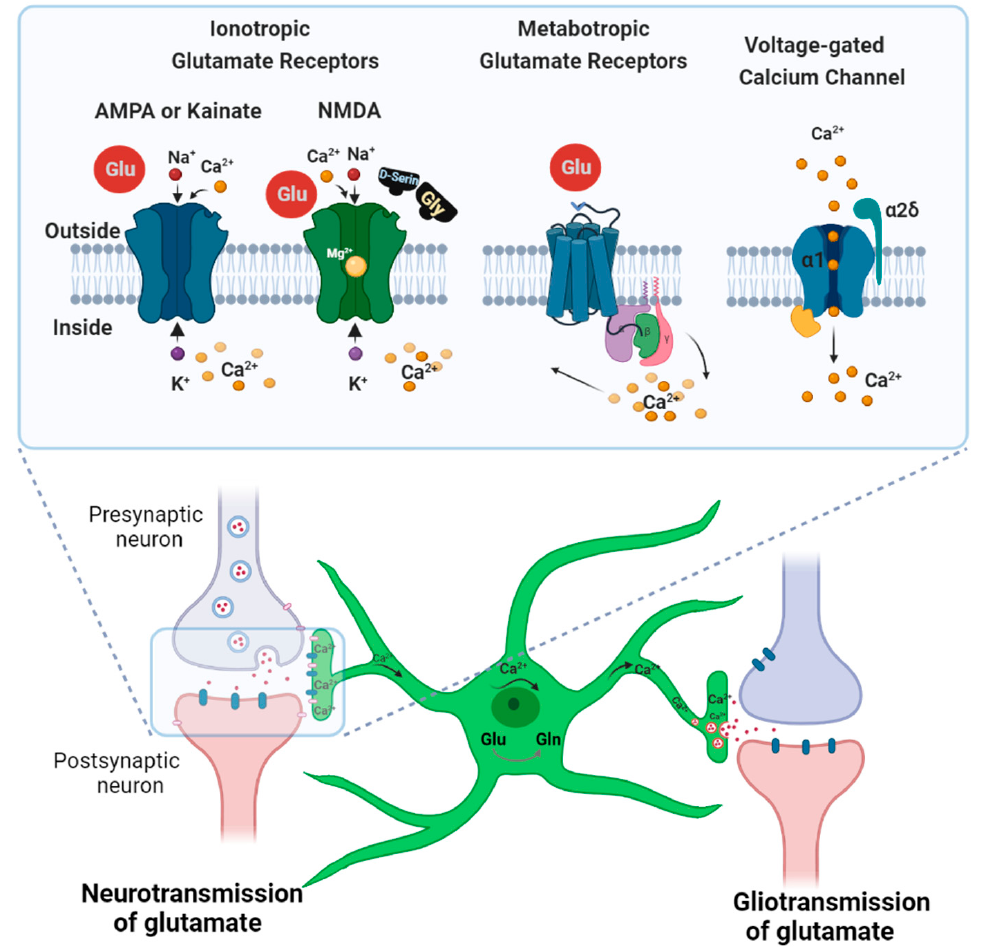
Figure 3. Scheme outlining glutamate and calcium signaling in astrocytes at a glutamatergic synapse. Astrocytes respond to glutamate stimulation with a strong calcium influx, followed by process extension. Such transient increases in Ca 2+ concentration in astrocytes can also cause gliotransmitter release. To prevent excitotoxicity, astrocytes also take up glutamate to recycle it into non-toxic glutamine [49]. Ionotropic (AMPA, KA, and NMDA) and metabotropic glutamate receptors contribute to the intracellular Ca 2+ rise in neurons and astrocytes. Voltage-gated calcium channels are also expressed at synapses in astrocytes and play a role in cellular calcium